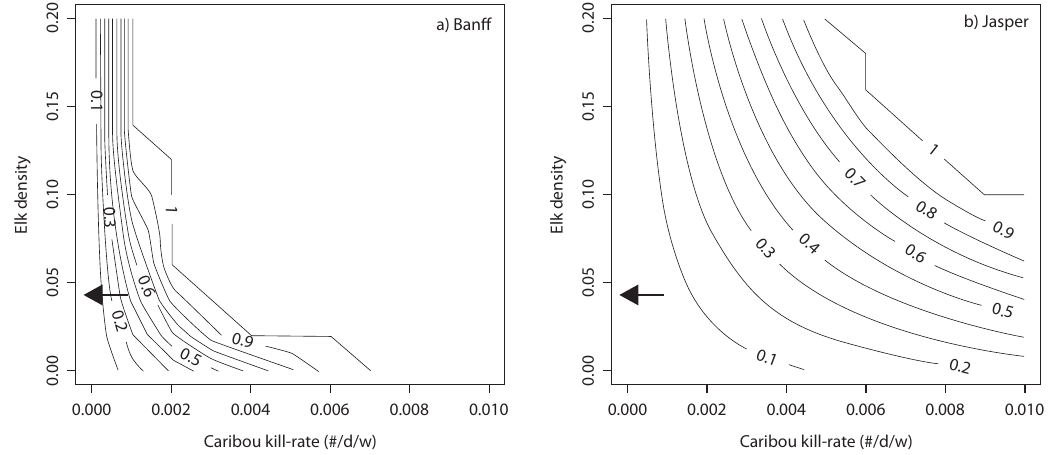
Fig. 3. Proportion of the a) Banff and b) Jasper caribou populations killed per winter (contours) by wolves as a function of elk density and a range of hypothetical wolf kill-rates (caribou killed per day per pack). Given current demog- raphy, caribou decline above a threshold of 0.15 and 0.20 wolf-caused mortality rate in Banff and Jasper. Differences between Banff and Jasper arise because of inverse density dependence in total predation rate driven by elk density (arrows mark current elk